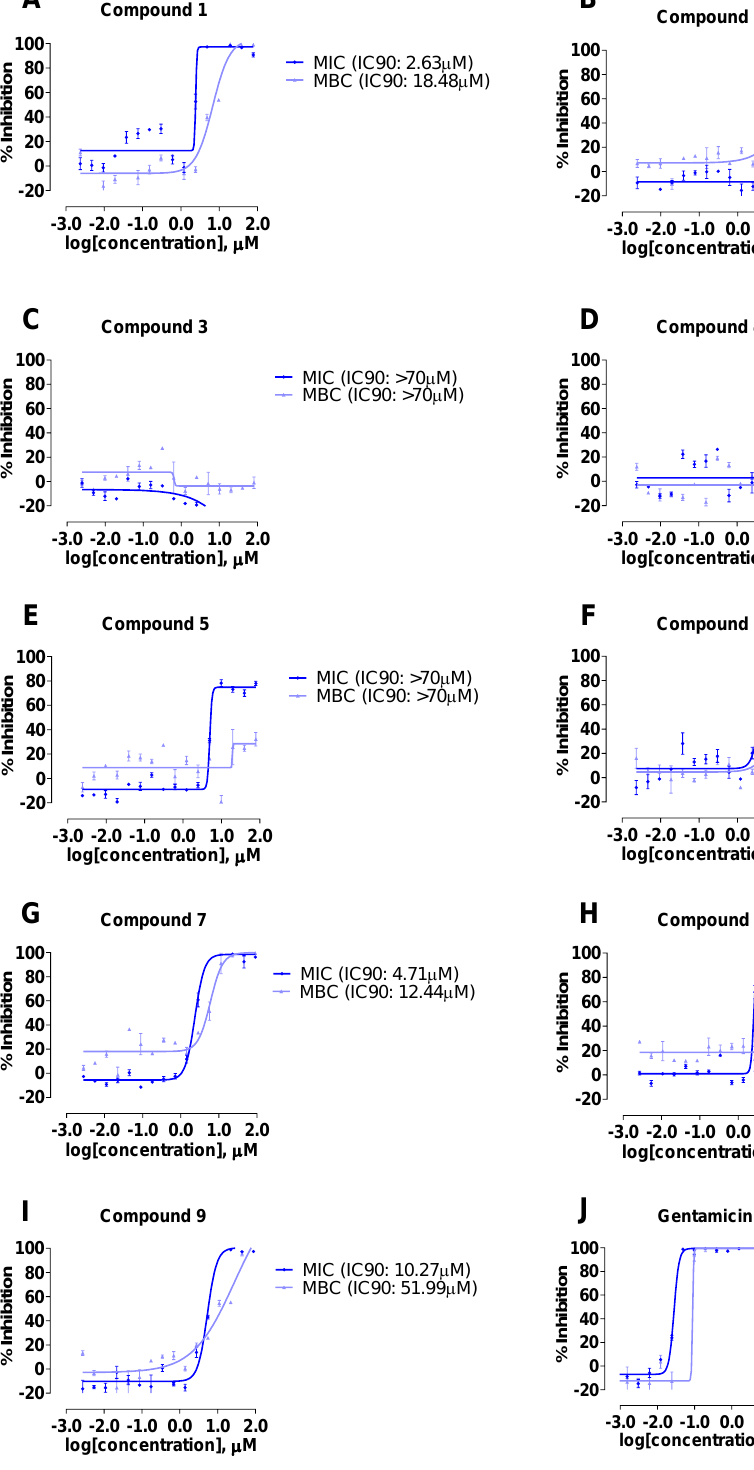
Figure 5. Inhibitory effect dose response curve against Staphylococcus aureus Rosenbach (ATCC ® 25923™) for compounds 1 – 9 (A – I) and positive control gentamicin (J).